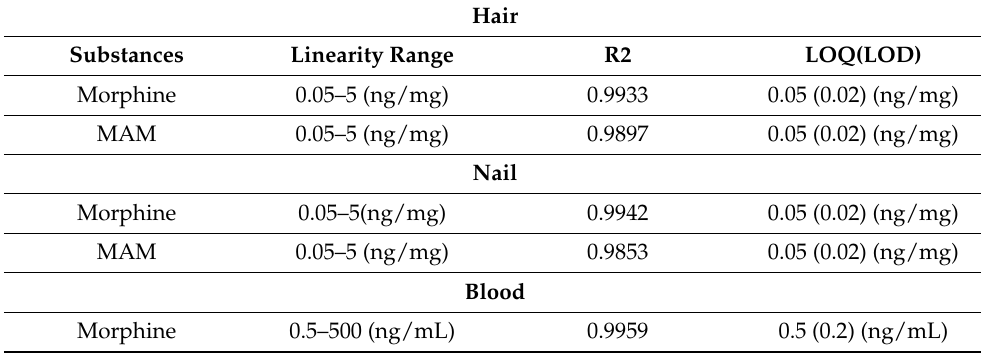
Table 2. Summary of validation results.